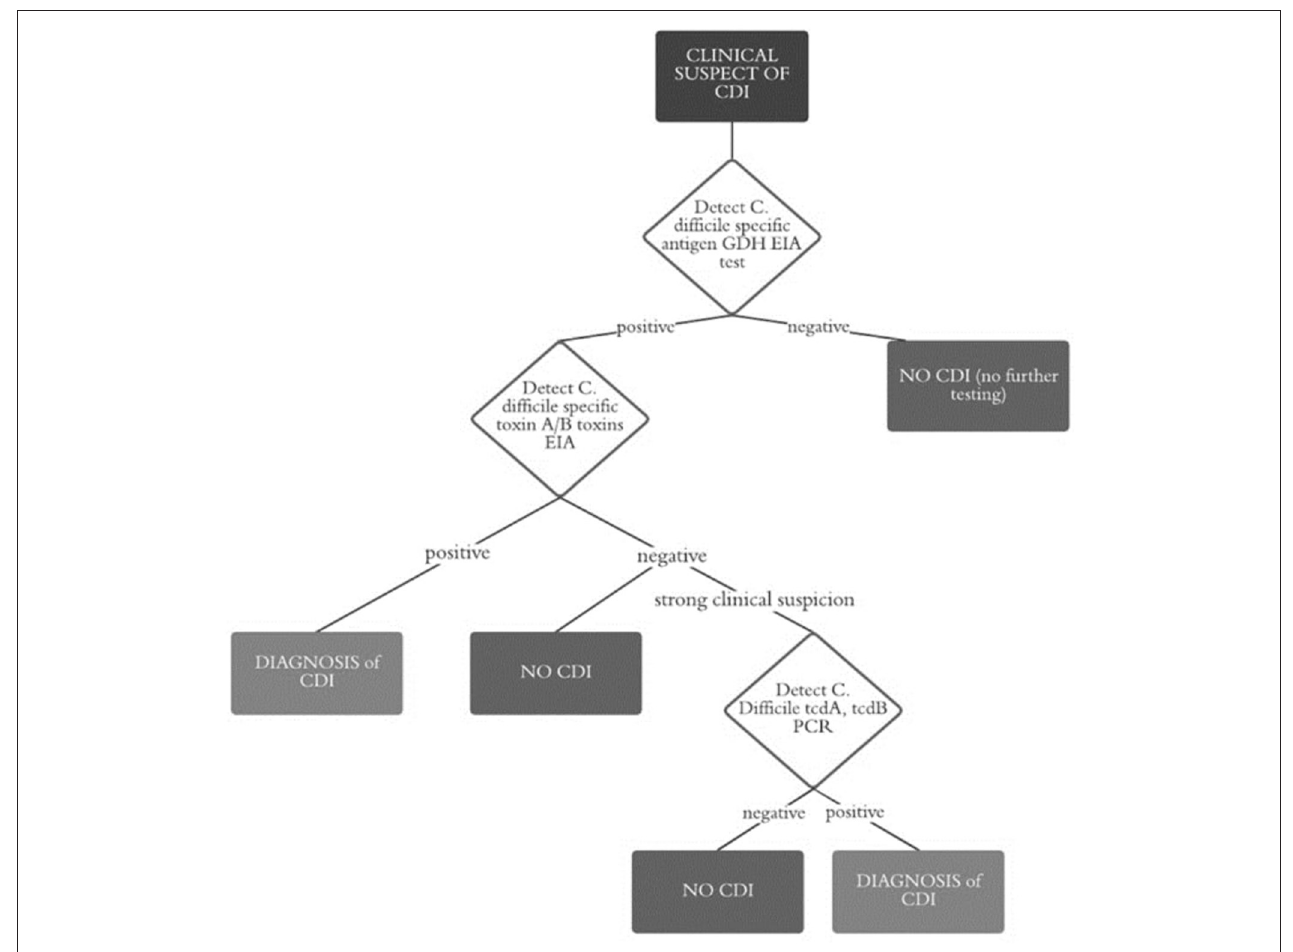
FIGURE 1 | Flow chart diagnosis of